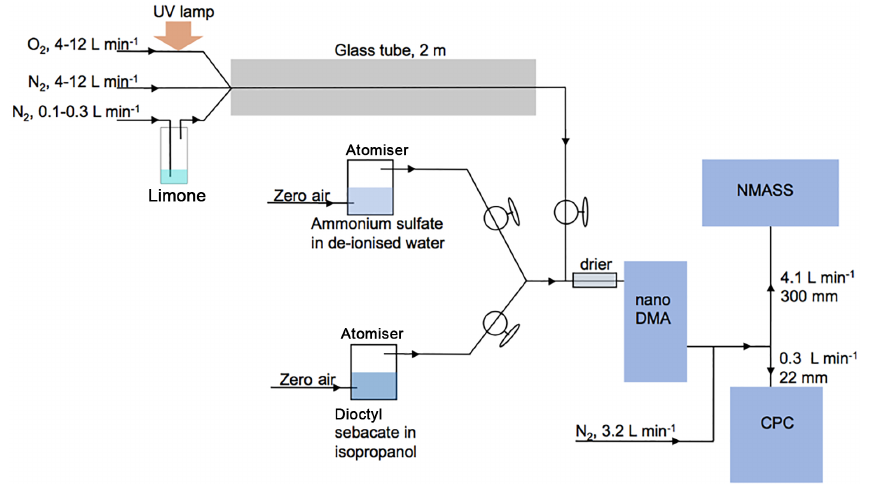
Figure 4. Diagram of the calibration set up used to characterize the NMASS counting efficiency as a function of particle diameter. The cali- bration includes different aerosol types such as limonene, ammonium sulfate, and dioctyl sebacate particles to test the instrument sensitivity to particle